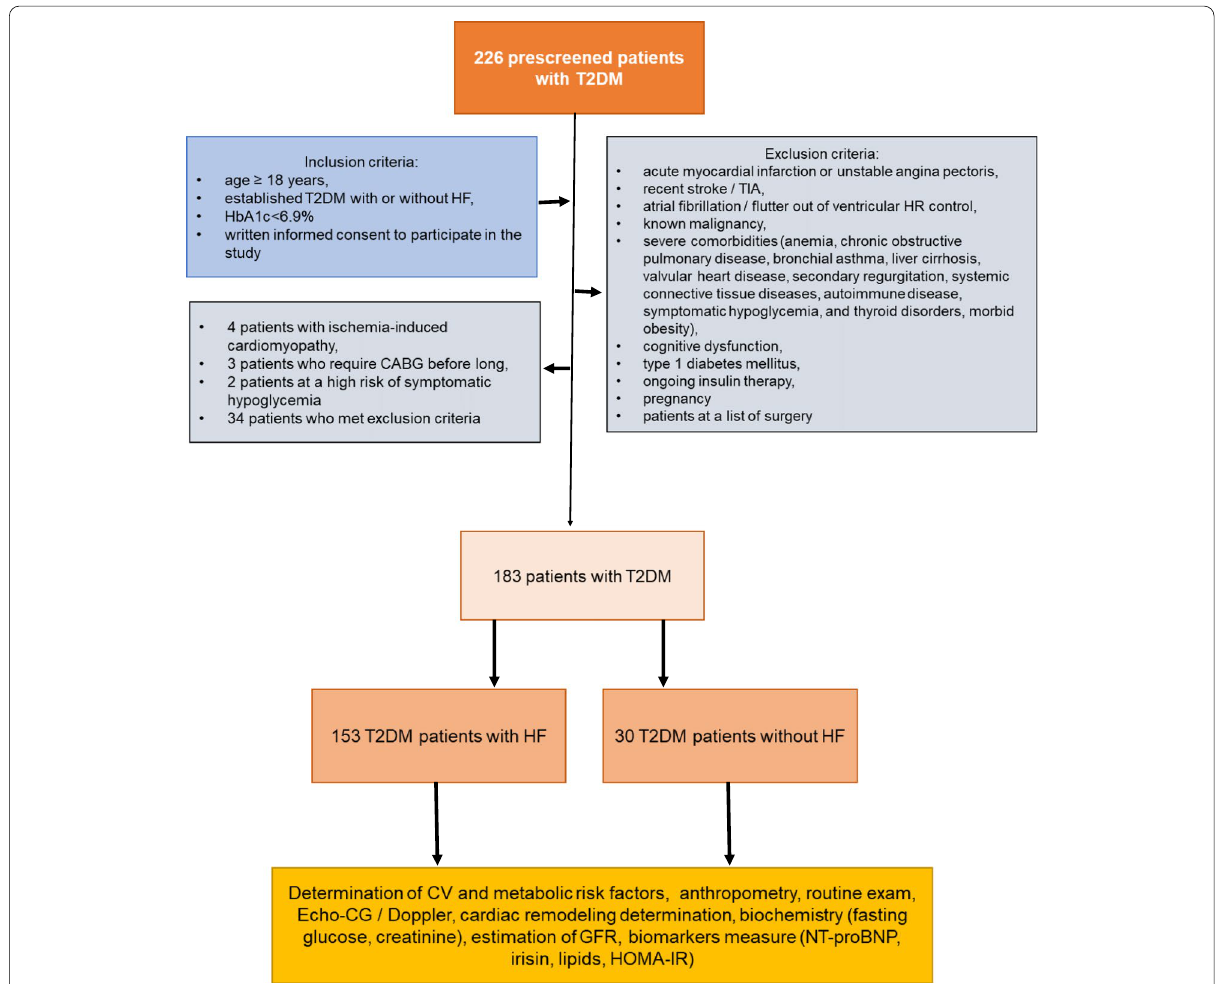
Fig. 2 Flow chart of the study design. Abbreviations: CABG, coronary artery bypass grafting; HF, heart failure; HOMA-IR, Homeostatic Assessment Model of Insulin Resistance; HR, heart rate; TIA, transient ischemic attack; T2DM, type 2 diabetes